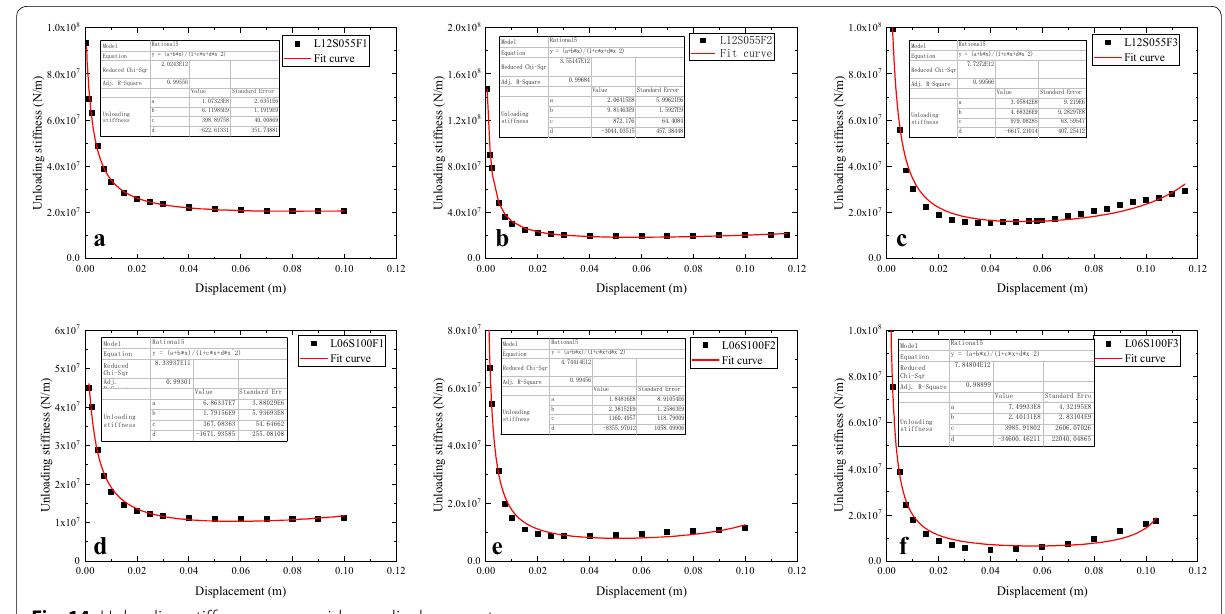
Fig. 14 Unloading stiffness versus midspan